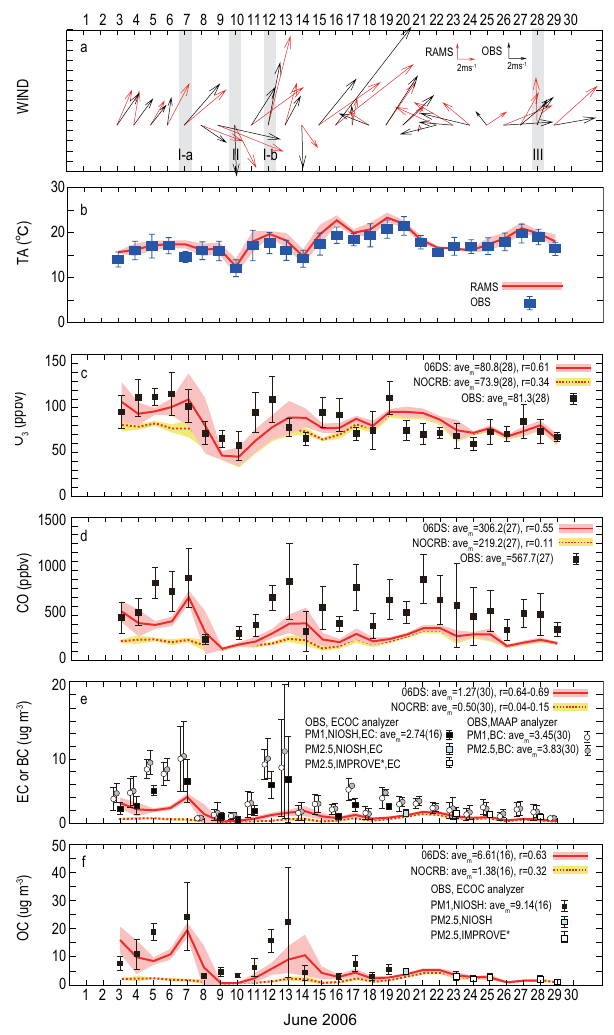
Fig. 6. Daily simulated and observed meteorological conditions and chemical concentrations at the summit of Mount Tai (36 ◦ N, 117 ◦ E, 1533m a.s.l.) in June 2006. (a) Simulated (RAMS) and observed (OBS) wind fields. (b) Simulated (RAMS, lines) and ob- served (OBS, squares) TA with SD ( ± 1 σ ) (simulated: shadow, ob- served: bars). Simulated (lines) and observed (squares) (c) O 3 , (d) CO, (e) EC or BC, and (f) OC with SD ( ± 1 σ ) (simulated: shadow, observed: bars). 06DS and NOCRB are simulated concentrations with and without daily emissions from open crop residual burn- ing, respectively. ave m is monthly average with sample numbers in brackets. r is correlation coefficient. EC or BC was observed by ECOC analyzer (Sunset Laboratory) and MAAP analyzer (5012 MAAP, Thermo). OC was observed by ECOC analyzer (Sunset Laboratory) (Kanaya et al.,